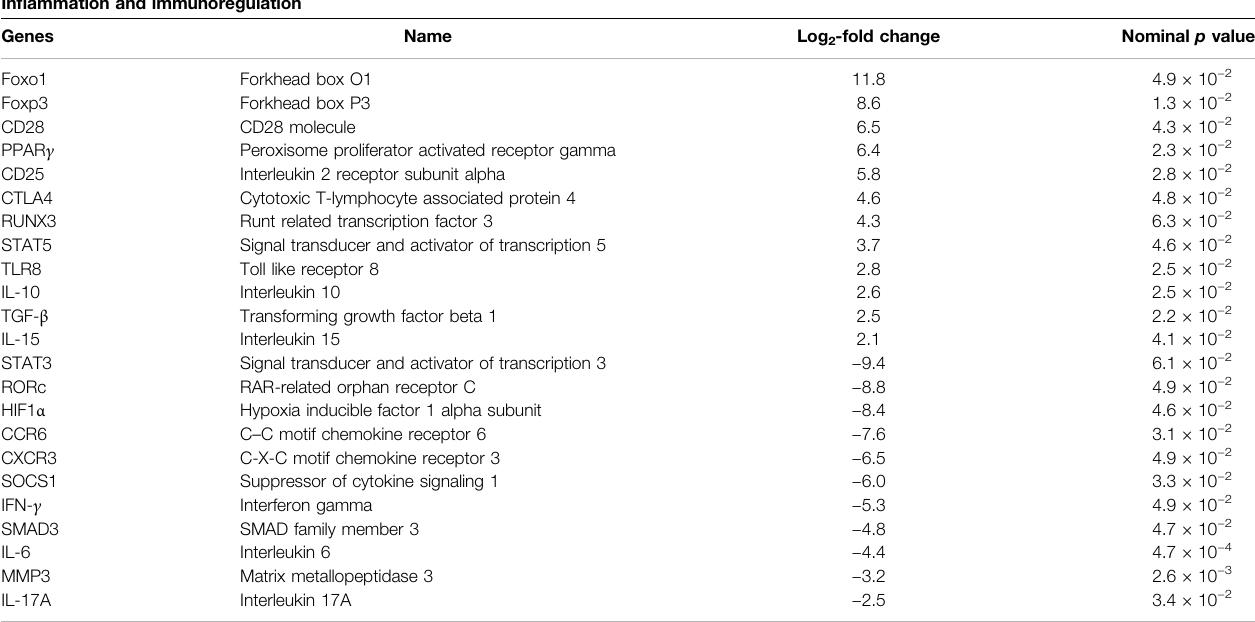
TABLE 4 | Selected genes linked to in fl ammation and immunoregulation in As 2 O 3 -treated RA Treg cells relative to control. In fl ammation and immunoregulation